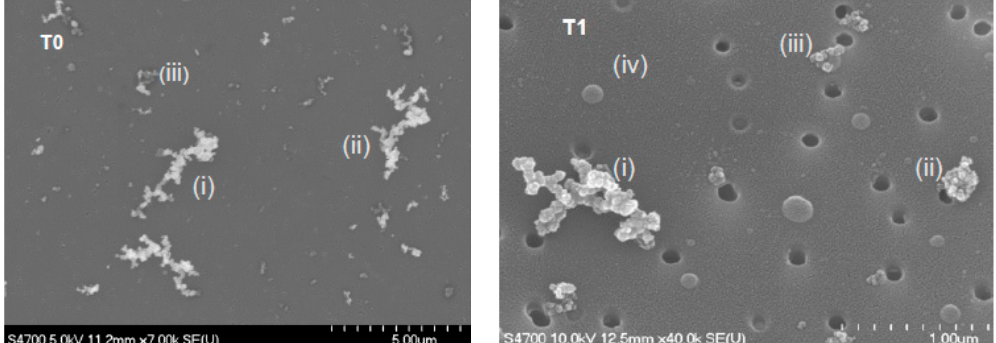
Figure 3. Field emission scanning electron microscope (FE-SEM) images of particles collected at T0 (left image) and T1 (right image) sites on nuclepore membranes, illustrating a broad distribution of fractal-like BC aggregates. FE-SEM image at T0, (i) elongated fractal-like BC aggregate, (ii) fresh BC mixed with coated BC, and (iii) darker region around the BC suggesting BC coated with other material (possibly organic matter). FE-SEM image at T1, (i) open fractal-like BC aggregate, ( ii) compact BC aggregate, (iii) partially-encapsulated BC with a spherical particle (top), and (iv) spherical particle. The dark circles are the holes in the collection substrate.